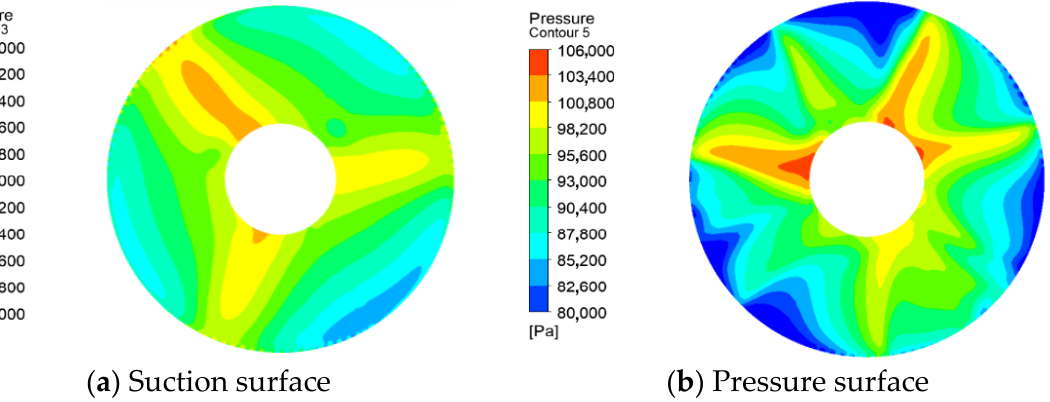
Figure 13. Q = 28 m 3 /s Static pressure distribution of the blade.